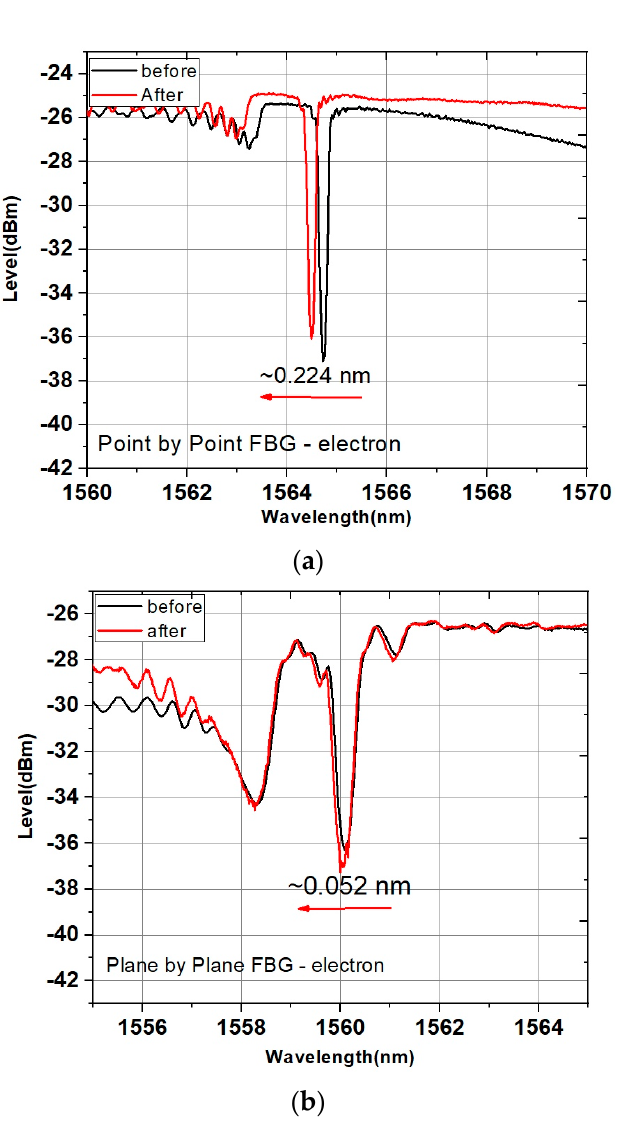
Figure 5. Transmission spectra of the FBG before and after the exposure to electron radiation, ( a ) PbP- inscribed FBG, ( b ) PlbPl -inscribed FBG.